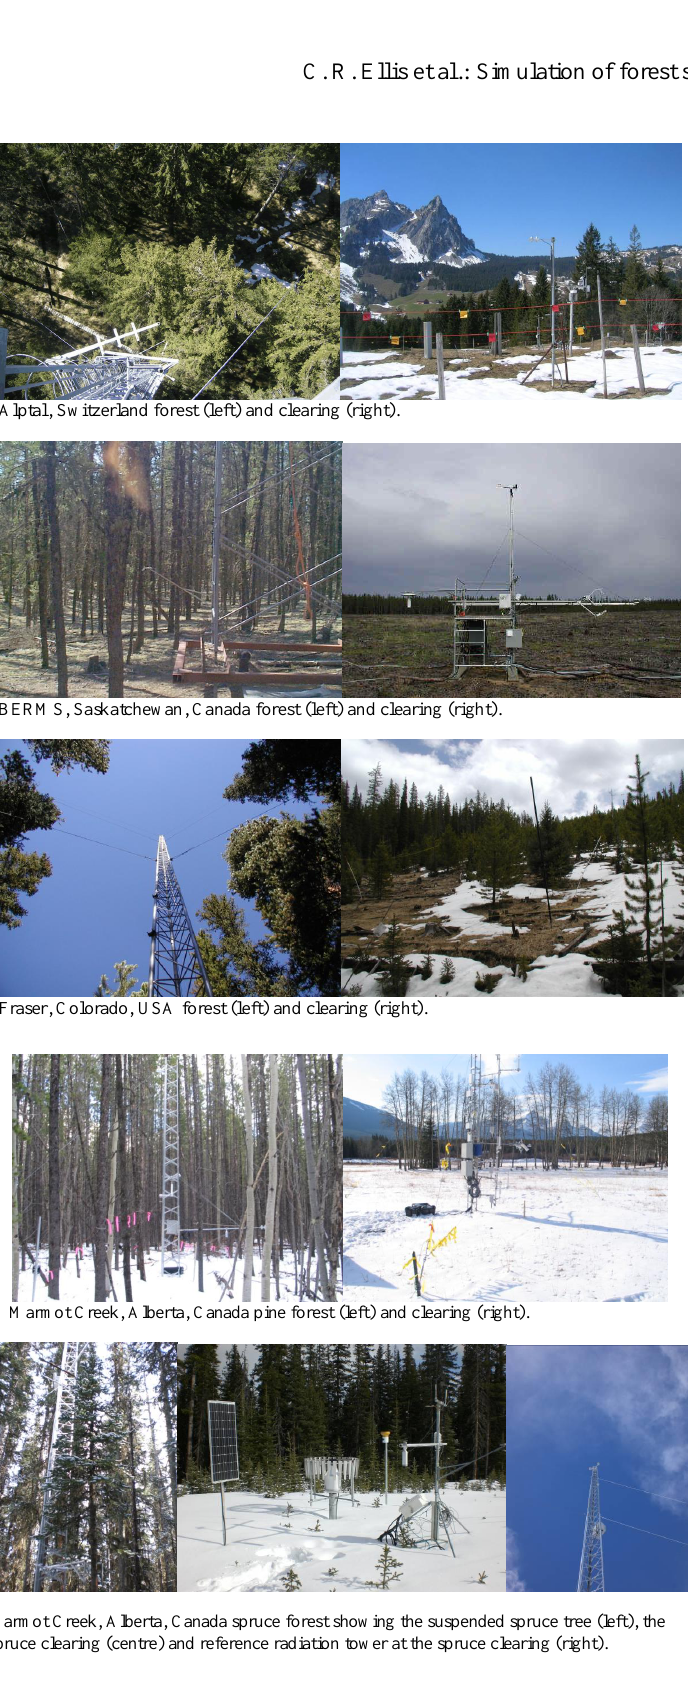
Figure 2. Photographs of meteorological stations located at forest and clearing sites at Alptal, Switzerland; BERMS, Saskatchewan, Canada; Fraser, Colorado, USA; and pine and spruce sites at Marmot Creek, Alberta, Canada (with the exception of the Marmot Creek sites, site photographs were provided by the SnowMIP2 facilitators).